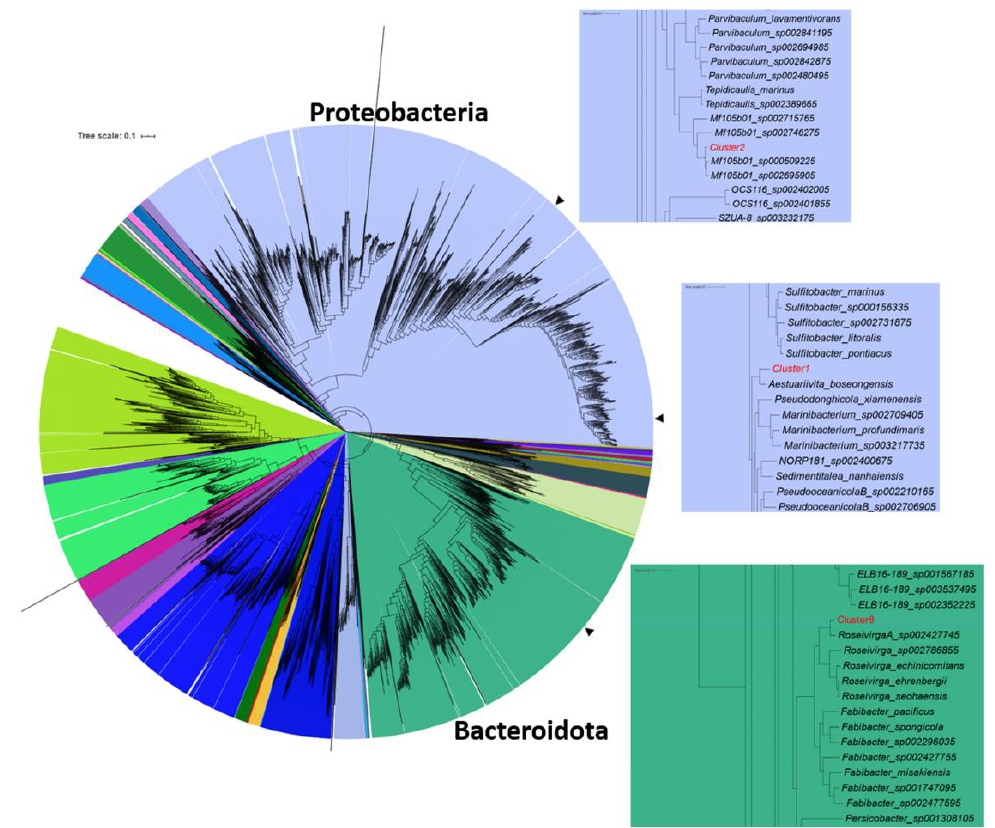
Figure 2. Phylogenetic placement of selected MAGs following analysis performed with GTDB-Tk [33]. The tree is colored by phylum. Arrows indicate the positions of the clusters in the tree and the insets show enlarged views of the region of the tree, including the selected clusters. Based on RAST analysis [34], we identified in Cl-1 the presence of genes encoding a photosystem II-type photosynthetic reaction center and a carotenoid pigment that may interact with the light harvesting